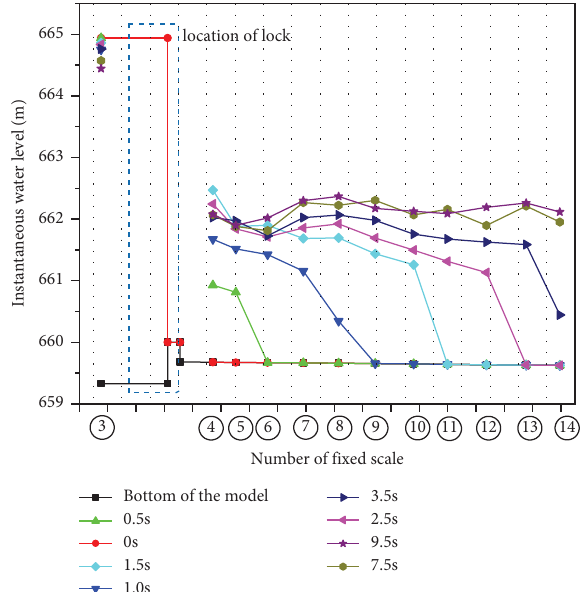
Figure 7: Instantaneous water surface profles at diferent